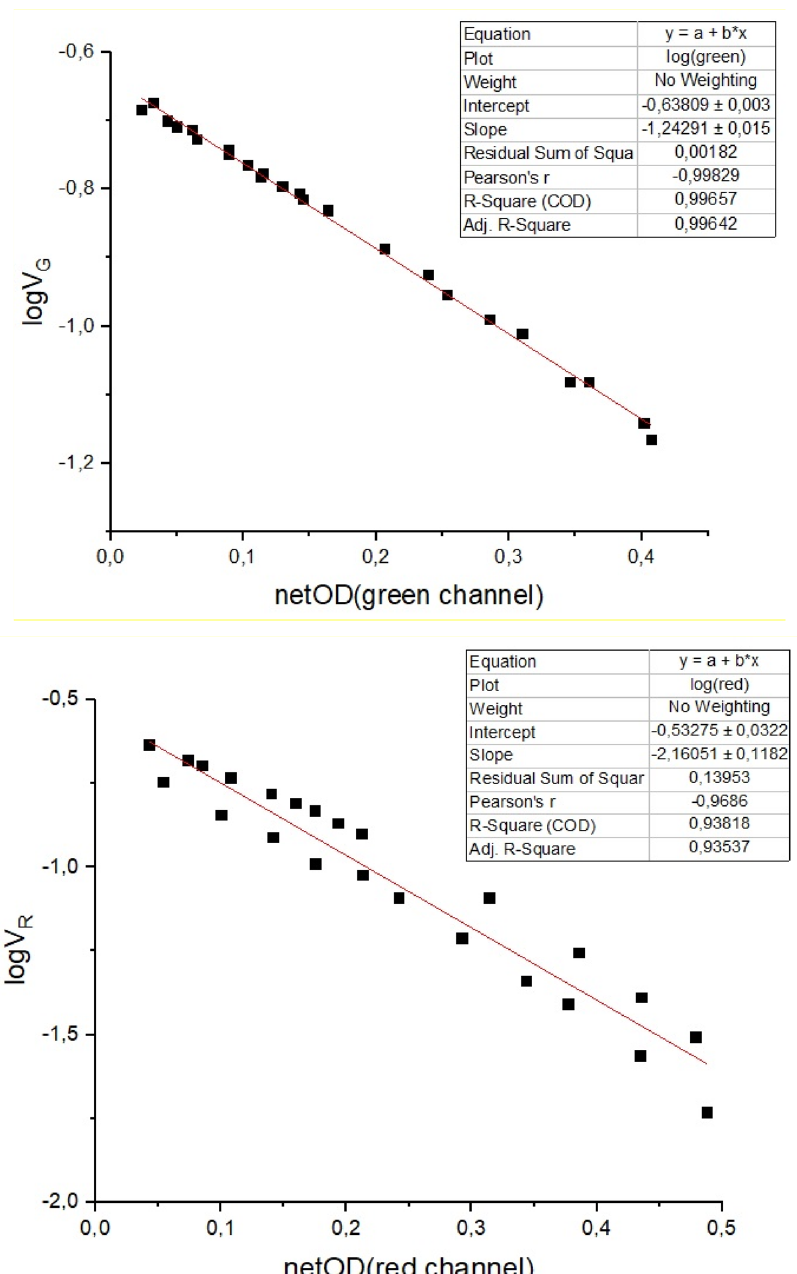
Figure 6. Photo-resistive voltage versus netOD obtained with both standard method for the green (top) and red (bottom) channels and using the MOEMS system for two independent gafchromic EBT3 film batches, namely those irradiated in the proton cyclotron and the photon LINAC